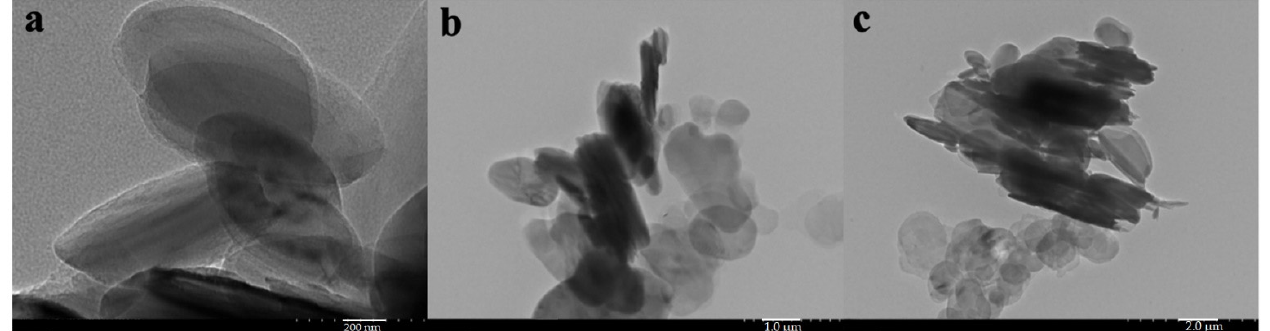
Figure 3. Images of hBN-NPs at different scales under the TEM: ( a ) 200 nm, ( b ) 1.0 μ m, ( c ) 2.0 μ m. A β -induced neurotoxicity potential and damage to membrane integrity were evalu- ated on differentiated SH-SY5Y cells (Figure 4) by MTT and LDH assays. Treatments with 1, 5, 10 and 25 mg/L of hBN-NPs did not alter the cell viability rates as compared to un- treated cells in MTT assay ( p > 0.05) (Figure 5). Likewise, 1, 5, 10, 25 and 50 mg/L of hBN- NPs did not lead to statistically significant elevations of LDH release when compared to untreated cells in LDH assay ( p > 0.05) (Figure 6). Moreover, the highest concentration of hBN-NPs (10 mg/L) caused around 12% reduction of cell viability rates. In fact, 500 mg/L of hBN-NPs led to decreases of cell viability rates in the rates of 25.0% and 41.4%, in MTT and LDH release assays, respectively (Figures 5 and 6). On the contrary, treatment of 50 μ M of A β 1-42 for 48 h nearly killed 50% of the total cell populations. In addition, we deter- mined the ameliorative effect of hBN-NPs against A β 1-42 induced neurotoxicity in differ- entiated SHSY5Y cells using MTT and LDH assays. According to the MTT cell viability assay, hBN-NPs were found to be more effective at the concentrations of 5 and 10 mg/L against A β 1-42 (Figures 7 and 8). Figure 4. ( a ) Undifferentiated SH-SY5Y cells; ( b ) SH-SY5Y cells differentiated via treatment with RA. TAC and TOS levels were carried out to understand the associated mechanism be- hind the neuroprotective action by hBN-NPs. The results showed that A β 1-42 caused a statistically significant decrease in TAC level and a significant increase in TOS level when compared to control ( p < 0.05). Moreover, when the cells treated with different concen- trations of hBN-NPs against A β 1-42 , the measured TAC level increased from 10.21 ± 0.14 to 17.09 ± 0.18 mmol Trolox Equiv./L, and TOS levels decreased from 12.35 ± 1.64 to 9.25 ± 0.67 mmol H 2 O 2 Equiv./l (Figures 9 and